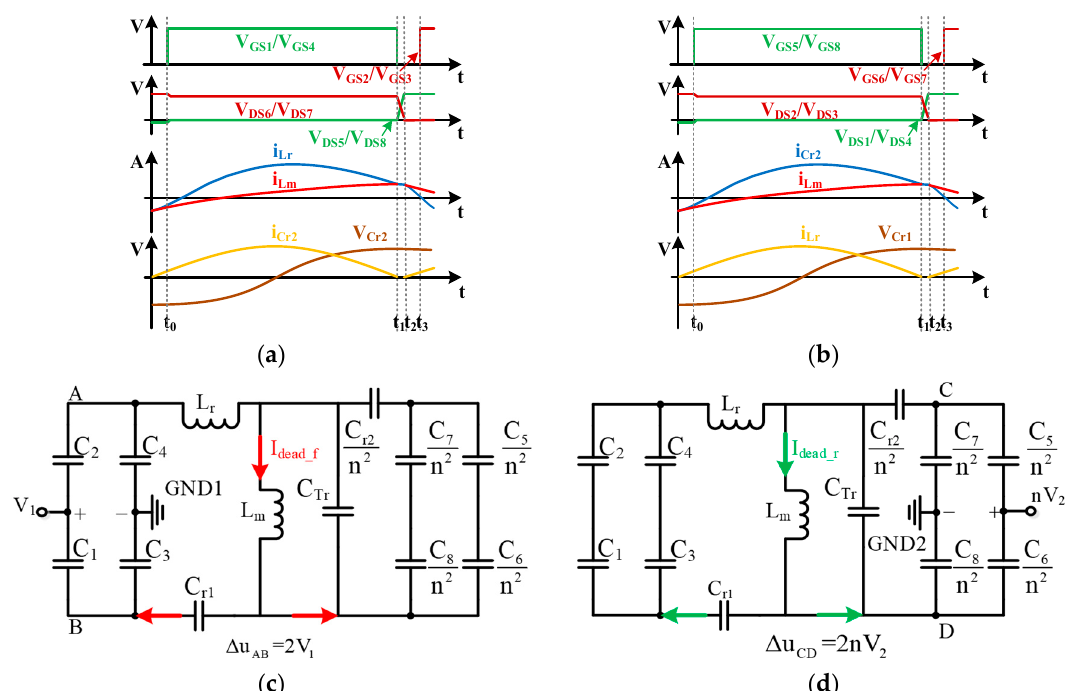
Figure 5. Analysis diagram of ZVS. ( a ) Critical waveforms of the forward mode; ( b ) critical waveforms of the reverse mode. ( c ) Charging and discharging circuit of the forward mode; ( d ) charging and discharging circuit of the reverse mode.